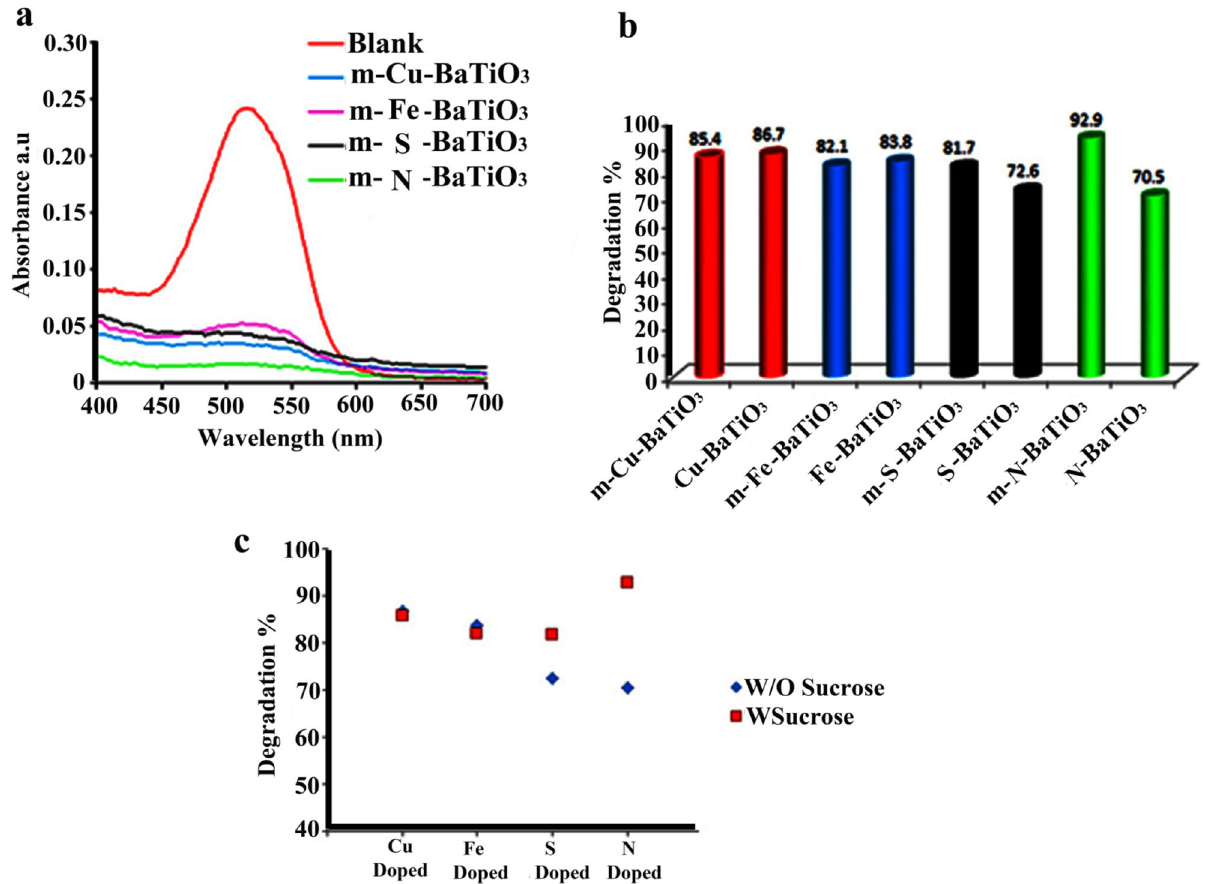
Figure 10. Effect of sucrose on piezocatalytic activity of doped BaTiO 3 to degrade AR151. ( A ) related UV–Vis spectra, ( b ) related degradation efficiency, and ( c ) compare degradation for sucrose and without sucrose.